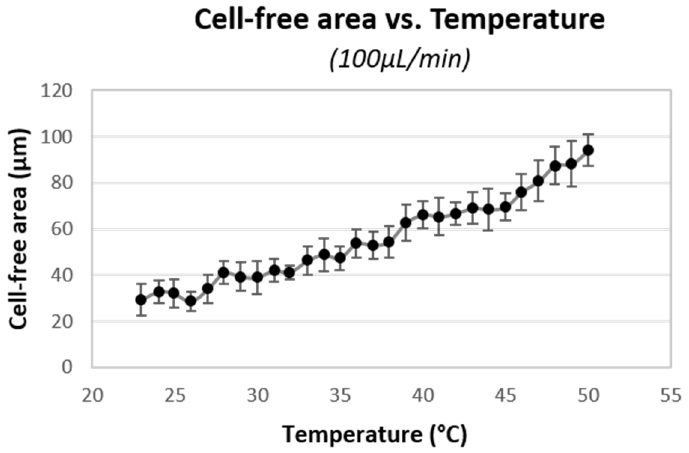
Figure 8. CFA measured at 100 μ L/min in a wide range of temperatures, from 23 °C to 50 °C.